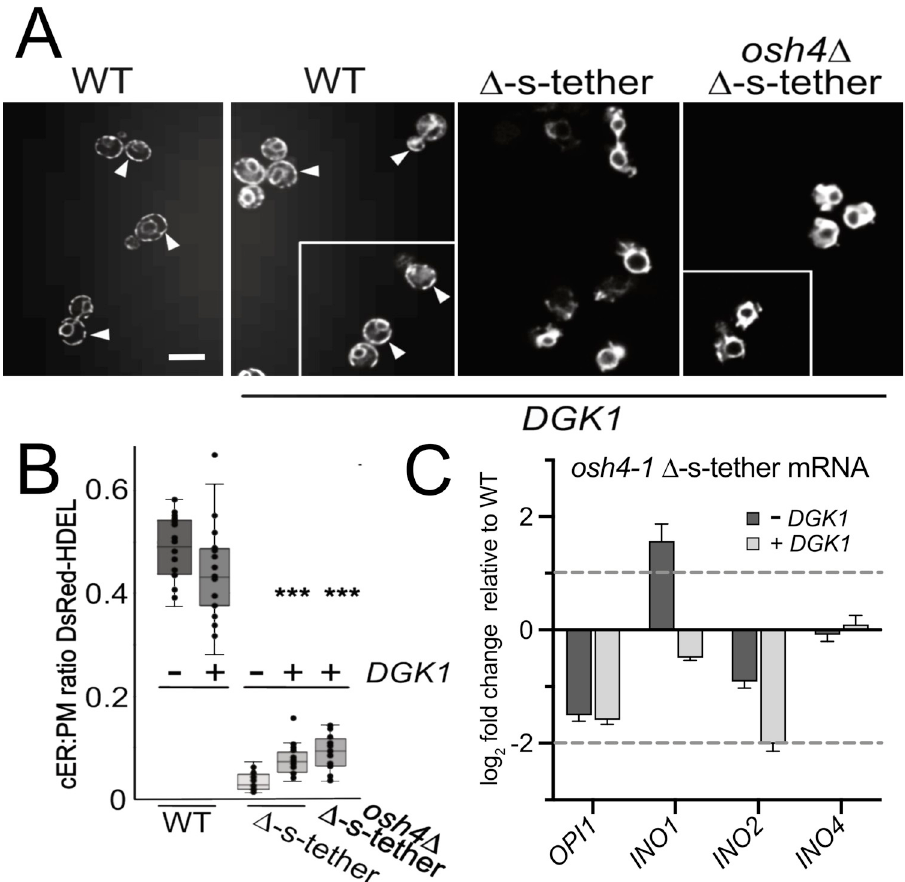
Fig 13. Representative fluorescent microscopy images of WT (SEY6210) and Δ -s-tether (CBY5838) cells both transformed with a control vector (YEplac181) or high-copy DGK1 (pCB1346), osh4 Δ Δ -s-tether cells suppressed with high-copy DGK1 (CBY6506), all expressing DsRed-HDEL (pRS416-DsRed-HDEL). Cells were cultured in synthetic growth medium at 30˚C. Arrowheads indicate examples of cortical ER association with the PM. ( B) Ratios of the total length of cortical DsRed-HDEL fluorescence (cER) per PM in WT, Δ -s-tether, and osh4 Δ Δ -s-tether cells with or without high-copy 2 μ DGK1 as indicated (n = 20 cells; statistical significance shown for Δ -s-tether versus Δ -s-tether and osh4 Δ Δ -s-tether cells transformed with high-copy DGK1 ; ��� p � 3 x 10 − 7 ). Box and whisker plots and statistics as described in Fig 1. (C) Relative to WT, mRNA levels of OPI1 , INO1 , INO2 and INO4 in osh4-1 ts Δ -s-tether (CBY6031) cells transformed with the vector (- DGK1 ) or high-copy DGK1 (+ DGK1 ) cultured at 37˚C for 1